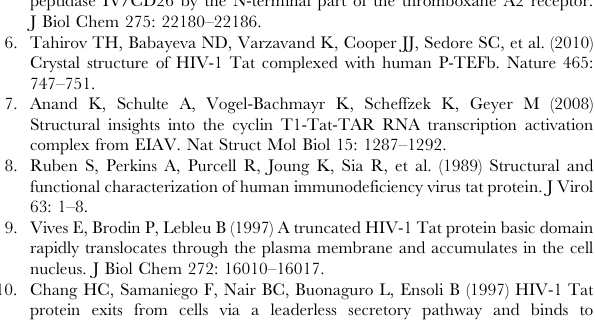
Table S1 Baseline characteristics of the study partici- pants. Table S2 Primers for amplifying HIV-1 Tat peptides. Table S3 Tat anti-sera reactivity to Tat